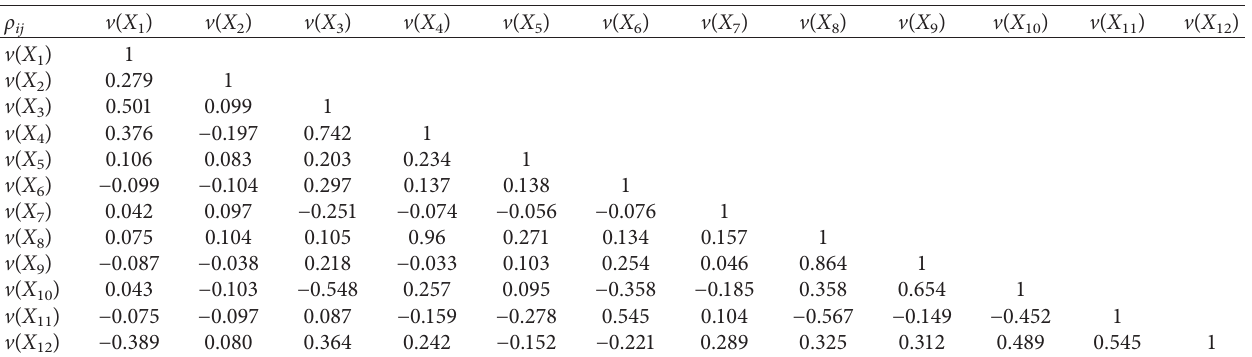
v ( X v ( X ij of i ) and j ).